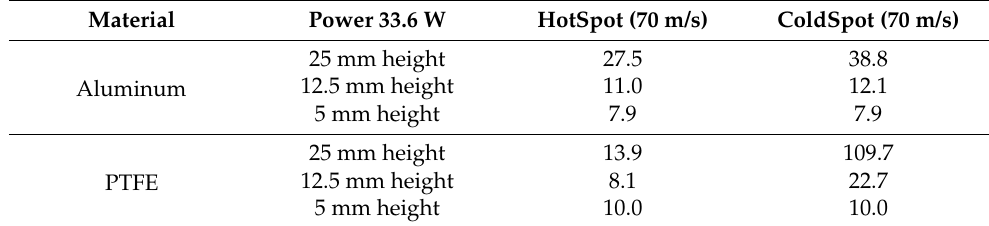
Table 6. Time elapsed to reach 5 ◦ C at HS and CS of various samples at 70 m/s.